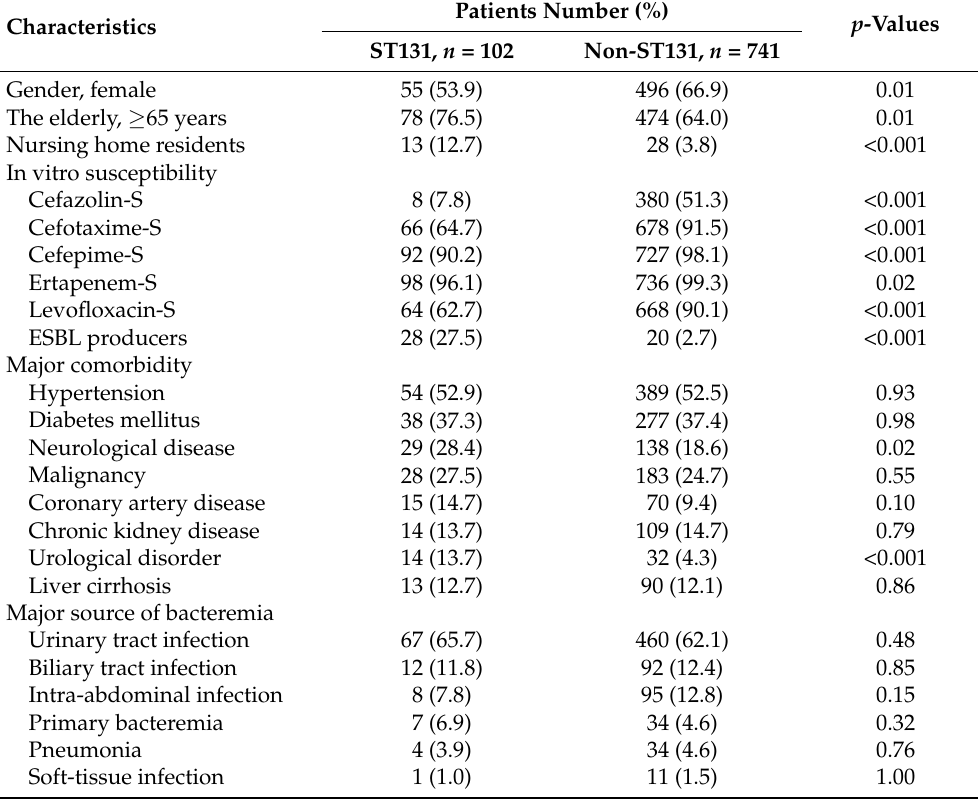
Table 1. Clinical characteristics of adults with community-onset monomicrobial Escherichia coli bacteremia due to sequence type 131 (ST131) and non-ST131